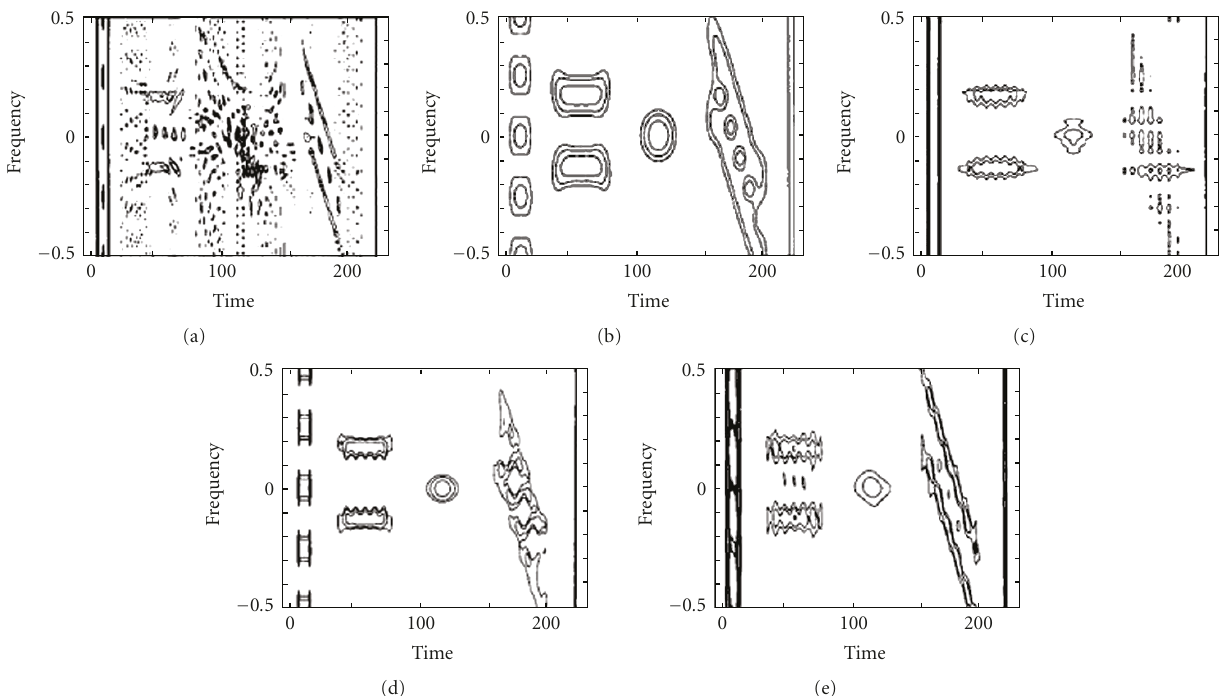
Figure 16: Comparison of several state-of-the-art TFDs of the synthetic test signal of three impulses, two simultaneous sinusoidal pulses, a Gaussian pulse, and two parallel linear chirps: (a) WD; (b) spectrogram computed with a 27- point Gaussian window; (c) Choi-Williams distribution with smoothing parameter α = 1 [29]; (d) cone-kernel representation with τ -extent parameter = 33 [146]; (e) radially Gaussian optimal-kernel TFD computed using volume α = 2 [118–120, 139] (adopted from Jones and Baraniuk [119]).